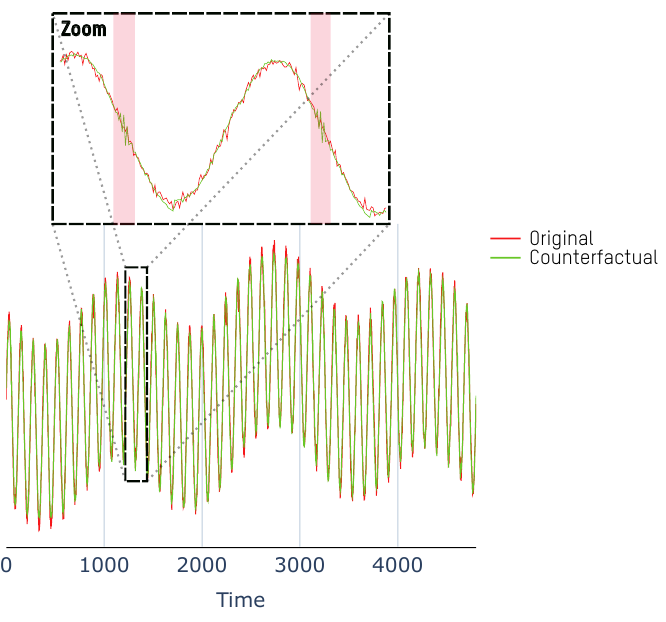
Figure 13. A normal sample and the counterfactual explanation for introducing anomalies.